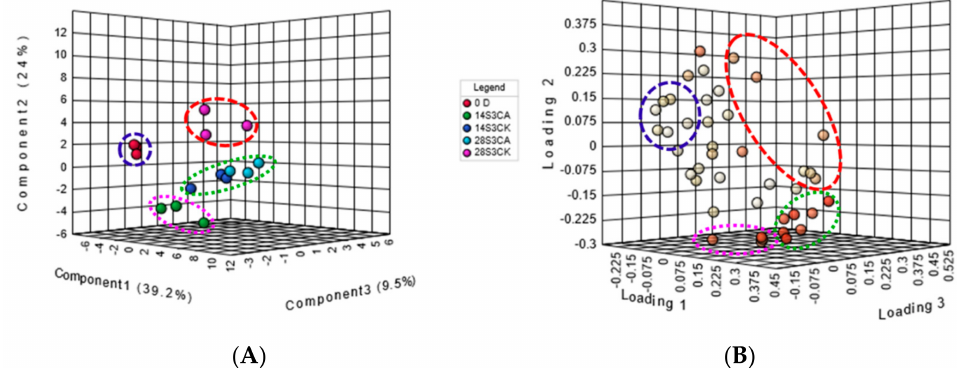
Figure 4. PLS-DA analysis of peach fruit VOC under CA treatment during shelf-life. ( A ) PLS-DA score plot of peach fruit VOC, the left one is the subfigure A; ( B ) Loading plot of peach fruit VOC with PLS-DA model, the right one is the subfigure B. The volatile compounds circled in different color circles were listed in Table